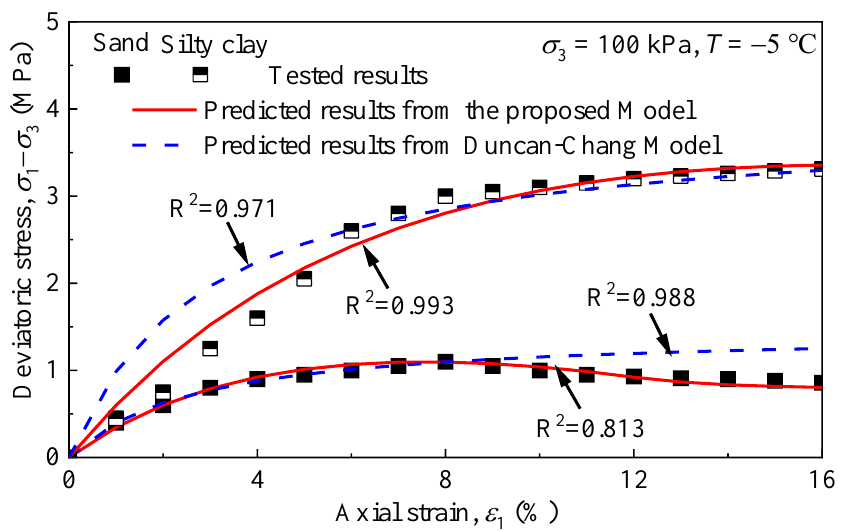
Figure 11. Comparison of the predicted and tested data of the tested remoulded fine-grained materials under T = − 5 °C and σ 3 = 100 kPa.